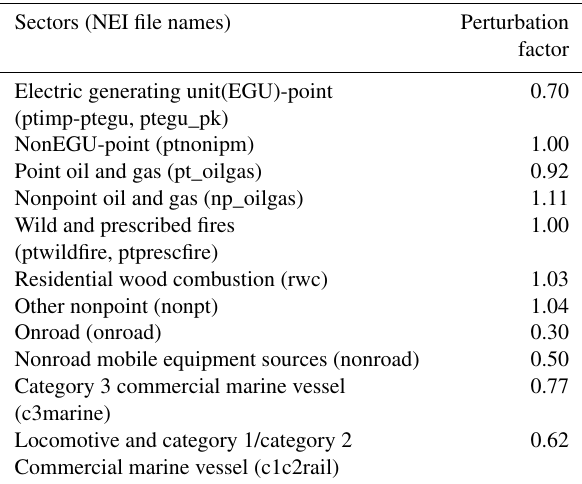
Table 4. Emission perturbation factors applied to anthropogenic NO x emissions for each sector listed in NEI as per EPA’s RIA base-line reductions from 2011 to 2025 with BAU (Table